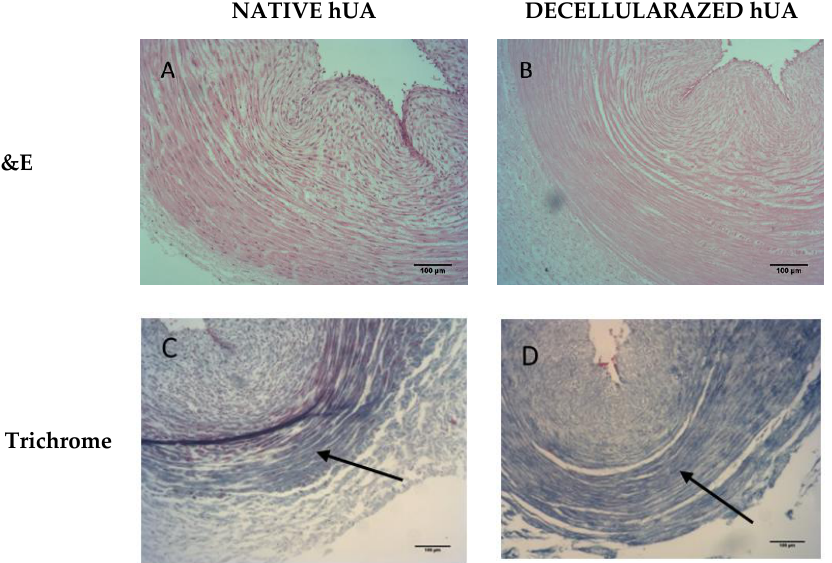
Figure 1. Native and Decellularized human umbilical artery stained with H&E (Hematoxylin and eosin stain), Masson’s Trichrome. Native hUA with ( A ) H&E, ( C ) Masson’s Trichrome. Decellularized hUA ( B ) H&E, ( D ) Masson’s Trichrome. Black arrows were indicated the collagen orientation. Original magnification 10 × , scale bars 100 µ m.